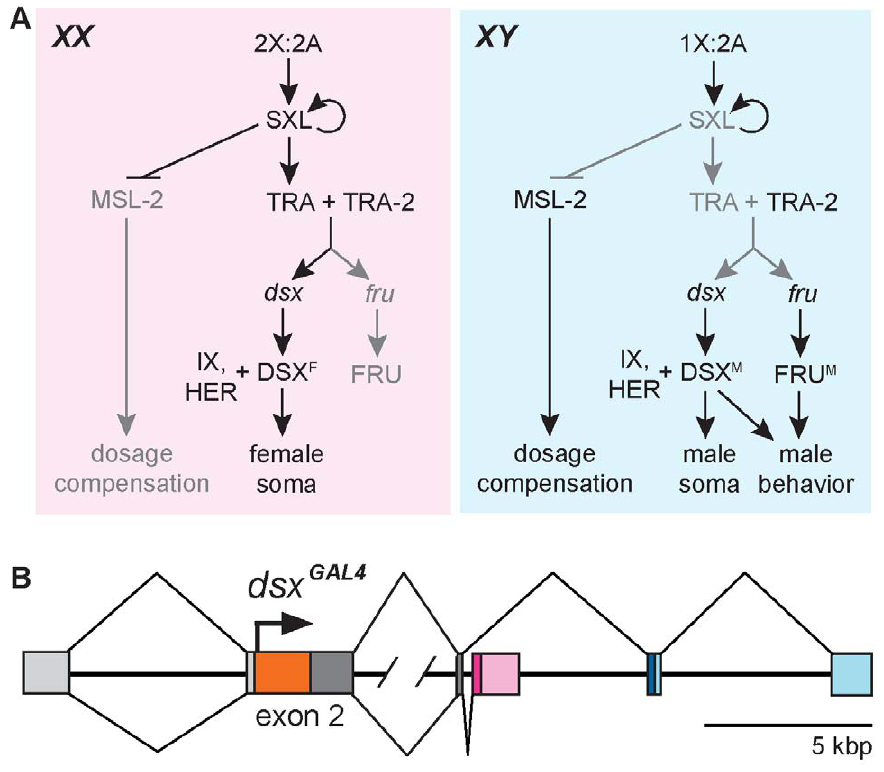
Figure 1. The Drosophila sex hierarchy. (A) The sex determination hierarchy in Drosophila regulates all sexually dimorphic aspects of development. The ratio of X chromosomes to autosomes determines the RNA splicing activity of SXL, which leads to sex-specific alternative splicing of dsx and fru transcripts at the bottom of the hierarchy. The resulting male- and female-specific DSX and FRU isoforms confer sexual identity to the cells in which they are produced. (Adapted from [2].) (B) The dsx GAL4 gene. Targeted insertion of GAL4 coding sequence (orange box) after the translational start codon (arrow) of dsx in exon 2 allows expression of GAL4 wherever dsx is expressed. Chromosomal sequences are color-coded as follows: 5 9 UTR sequences common to the mRNAs of both sexes (light gray), N-terminal coding sequence common to mRNAs of both sexes (dark gray), coding and 3 9 UTR sequences specific to females (magenta and pink, respectively), coding and 3 9 UTR sequences specific to males (dark and light blue, respectively), and intronic sequences (black line). Male-specific and female-specific splicing patterns are depicted above or below the chromosome, respectively. Slash marks in the second intron represent , 24 kb of DNA.